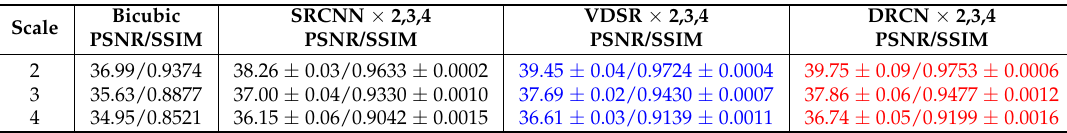
Table 10. Multiple scale super-resolution results of networks trained and tested on BUAA-SID 1.0 (mean standard deviation). The red font indicates the best performance, while the blue font indicates ± the second